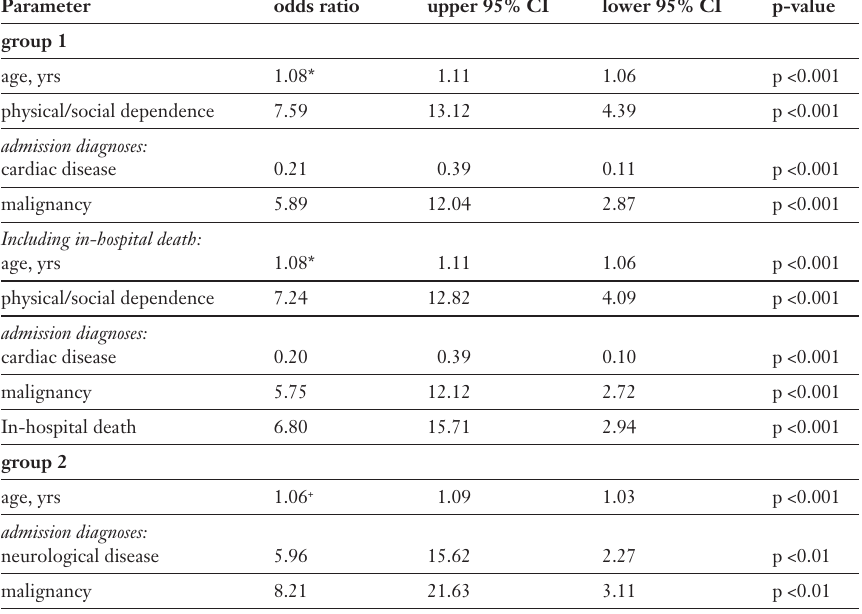
Table 2 Final multivariate logistic regression models for the de- pendence of DNR orders on various parameters in group 1 and group 2.